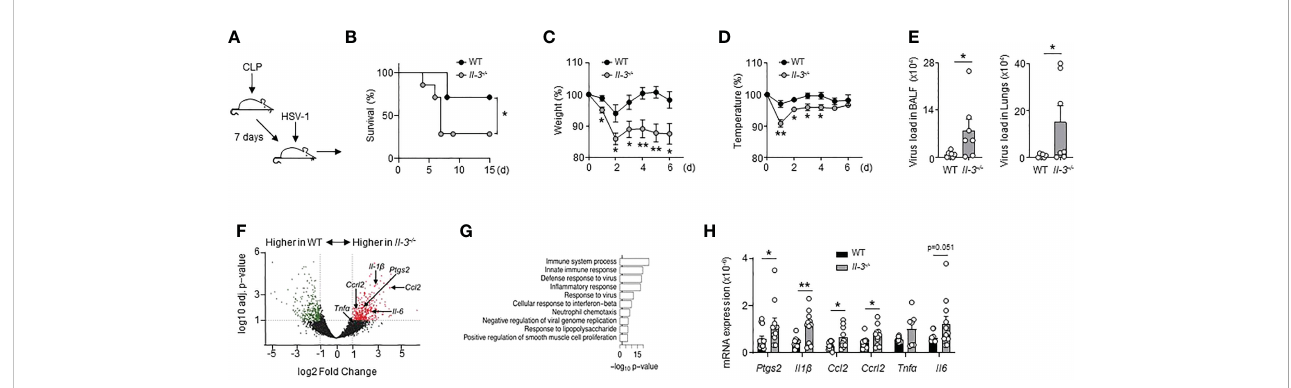
FIGURE 2 Interleukin-3 protects against pulmonary viral infection during sepsis. (A – H) Sub-lethal sepsis was induced in WT and Il-3 -/- mice using the CLP model, and 7 days later, mice were intranasally infected with 1.5x10 7 PFU of HSV-1 during 3 days. (A) Schematic representation of sepsis induction and infection. (B) Survival curve (n=7/group). Data were analysed by Log-rank (Mantel-Cox) test. (C) Percentage of weight loss (n=8). (D) Body temperature percentage (n=8). (E) Viral load in the BALF and lungs (n=8). (F) Volcano plot representation showing genes increased in the lungs of CLP WT mice compared with CLP Il-3 -/- mice (n=5). (G) Top 10 over-represented GO term results ordered according to their p-value for the full set of differentially expressed genes identi fi ed by DESeq2 ( Il-3 -/- vs. WT). (H) Relative mRNA expression of genes identi fi ed by volcano plot in the lungs of septic WT or Il-3 -/- mice (n=13). Data are mean ± s.e.m., *P < 0.05, **P < 0.01, unpaired, 2-tailed Student ’ s t test using Welch ’ s correction for unequal variances was